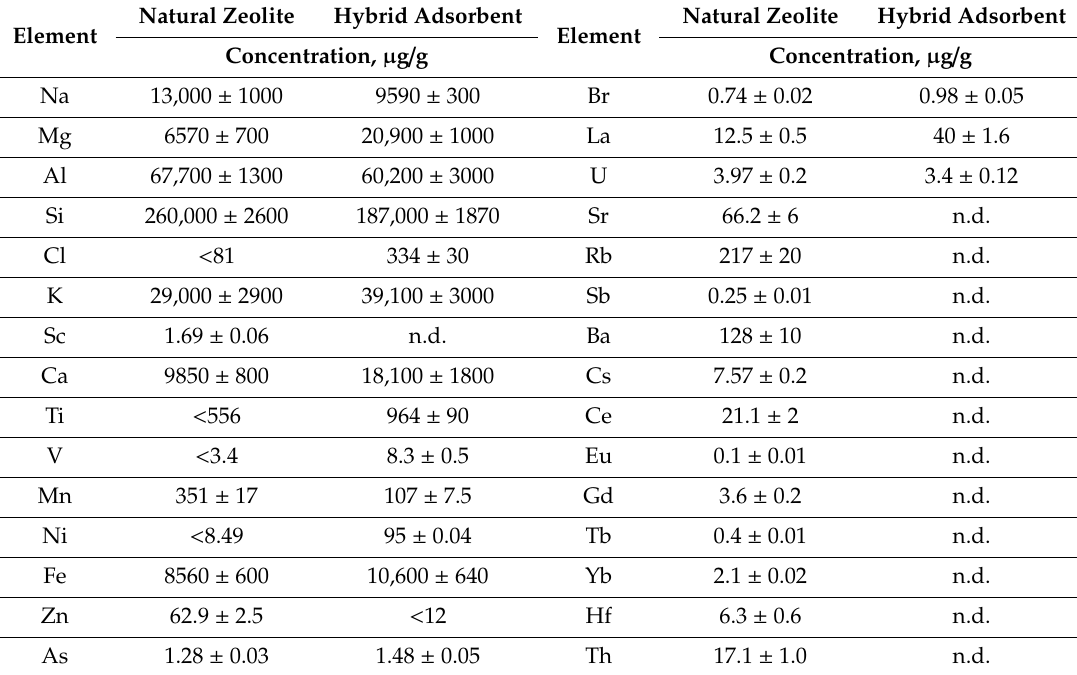
Table 3. Elemental content of natural and bio-zeolite determined by neutron activation analysis NAA.